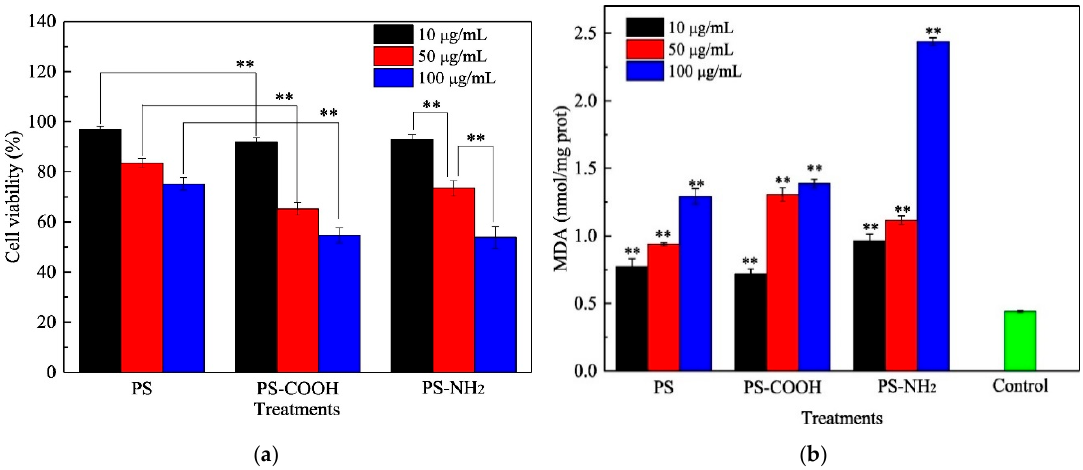
Figure 9. Effects of PS, PS-COOH, and PS-NH 2 at different concentrations on cell viability and malondialdehyde (MDA) content in HepG2 cells. ( a ) The cytotoxicity of the NPs was measured in HepG2 cells using 3-(4,5-dimethylthiazol-2-yl)-2,5-diphenyltetrazolium bromide (MTT) viability assay. ( b ) The MDA level for oxidative stress in HepG2 cells after treatment of NPs was detected using the corresponding detection kit. Control indicates HepG2 cells treated with the vehicle. ** p < 0.05, according to the analysis of variance test [20]. (Reprinted with permission from [20]. Copyright 2017 Elsev.)